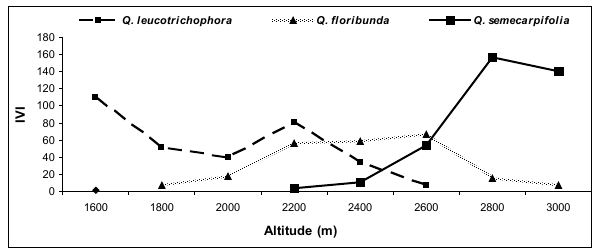
Fig. 1. Dominance (IVI) of oak species at different altitude